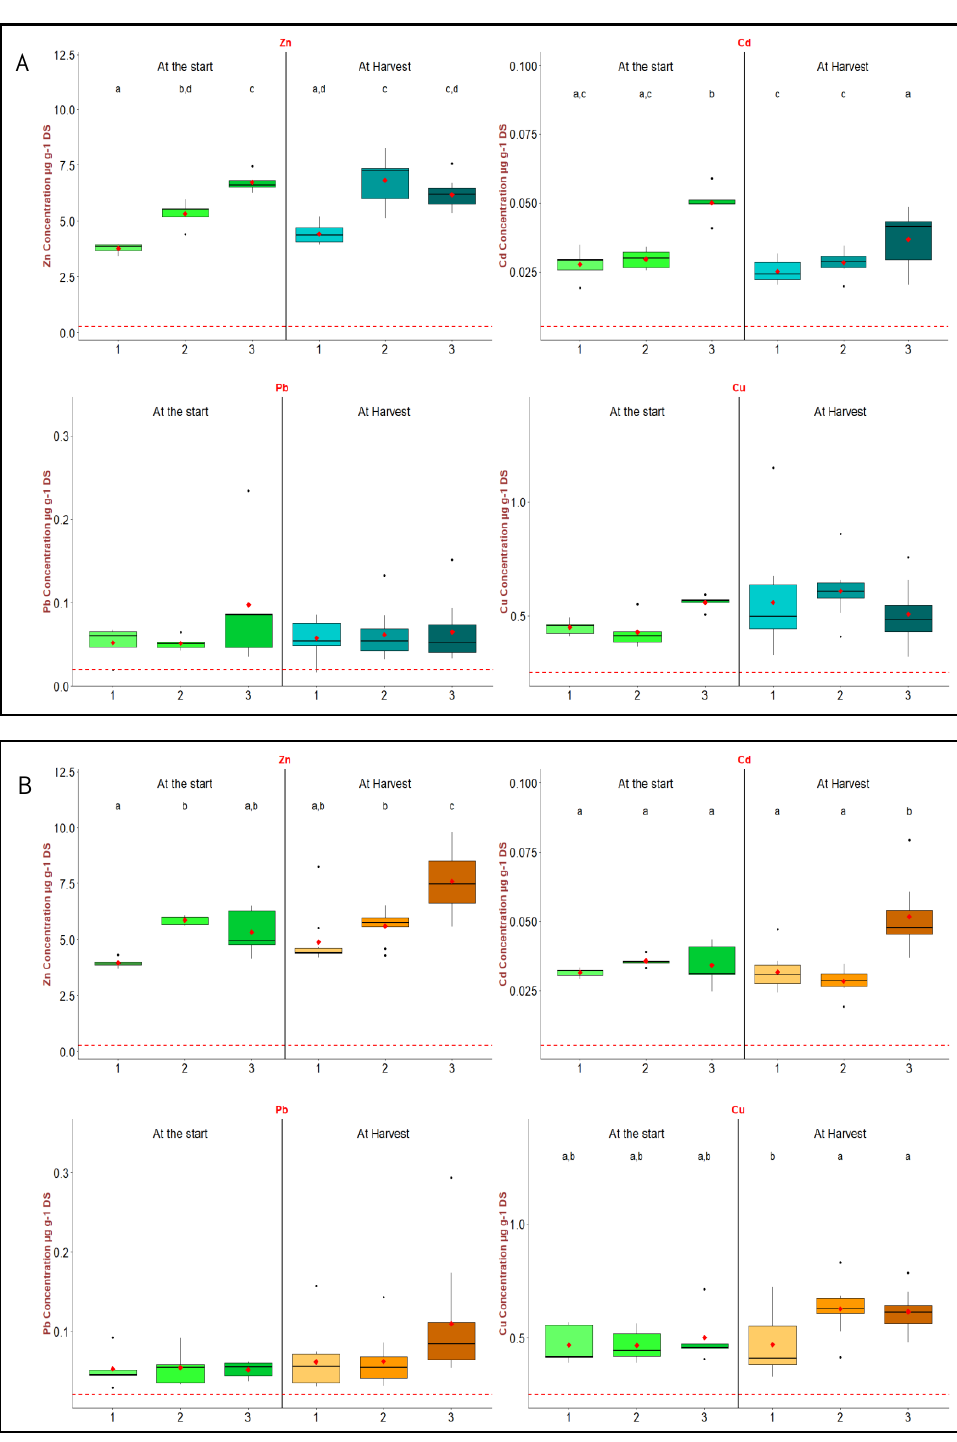
Figure 2. Sediment NH 4 NO 3 extractable concentration of Zn, Cd, Pb, and Cu at the start (green), at harvest of sorghum Biomass 133 (blue, A ), and at harvest of sorghum Trudan Headless (orange, B ) for the 3 areas (1 = area 1, 2 = area 2, 3 = area 3). The box plots indicate the median and the 25 and the 75 percentiles; red diamond = mean; the dotted red line corresponds to the value references noticed in the ISO 19730:2008 (E). Significant differences between conditions are indicated by different letters at the level of α = 0.05.